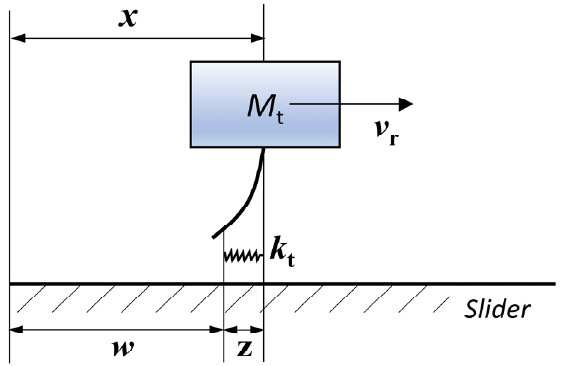
Figure 5. Illustration of Dahl friction model for the standing-wave ultrasonic motor.